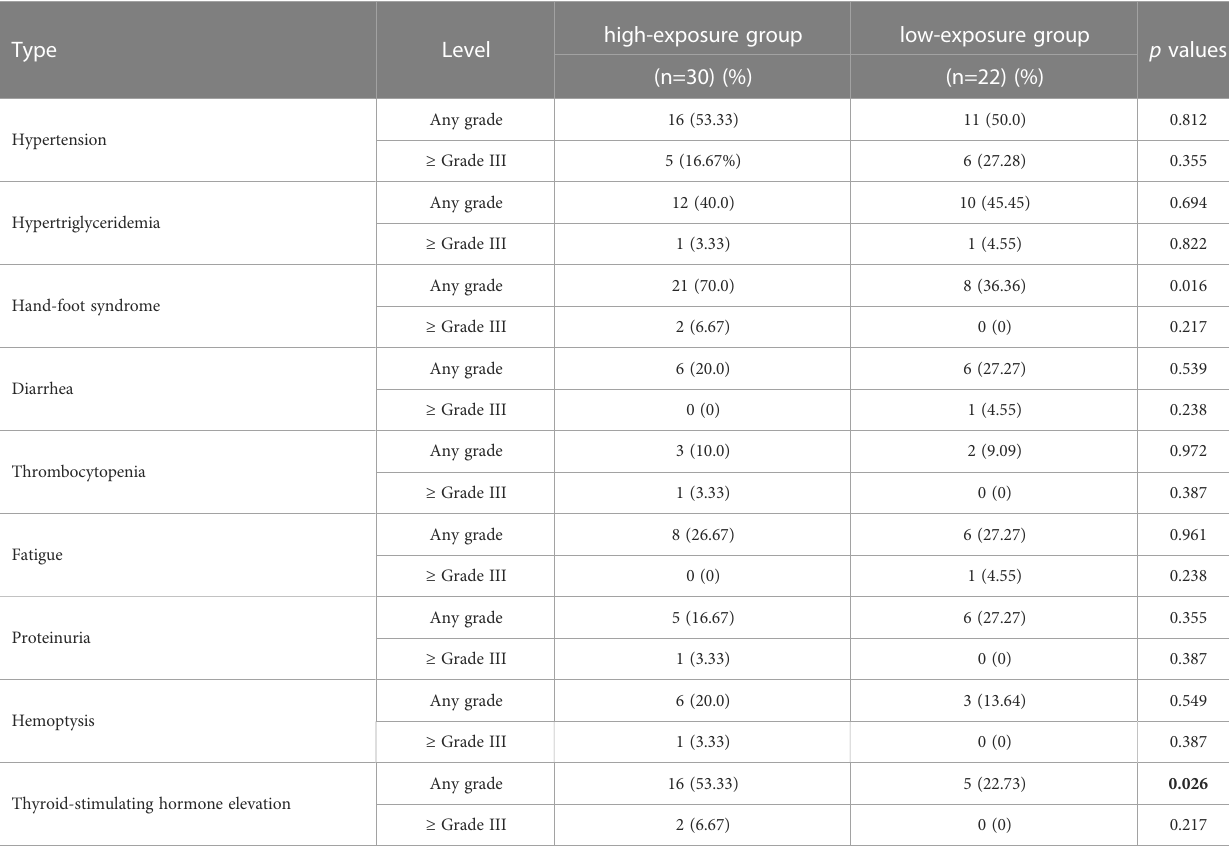
TABLE 4 Comparison of adverse events in patients with ANL C trough ≥ 10.29ng/ml (high-exposure group) and <10.29ng/ml (low-exposure